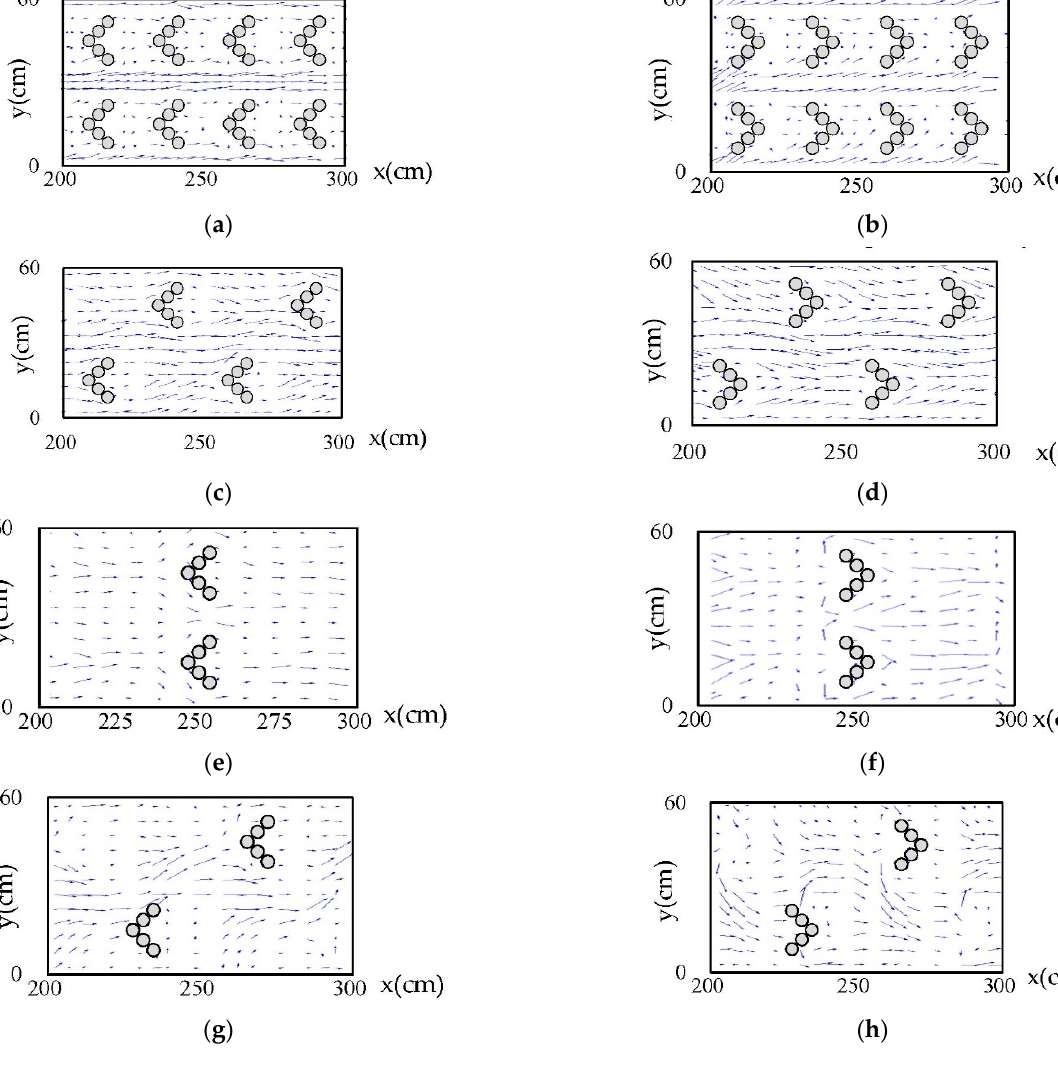
Figure 15. Flow velocities vector diagram in each case: ( a ) Run4-cu in Case 4 (previous study [4]); ( b ) Run4-cd in Case 4 (previous study [4]); ( c ) Run5-cu in Case 5 (this study); ( d ) Run5-cd in Case 5 (this study); ( e ) Run6-cu in Case 6 (this study); ( f ) Run6-cd in Case 6 (this study); ( g ) Run7-cu in Case 7 (this study); ( h ) Run7-cd in Case 7 (this study).